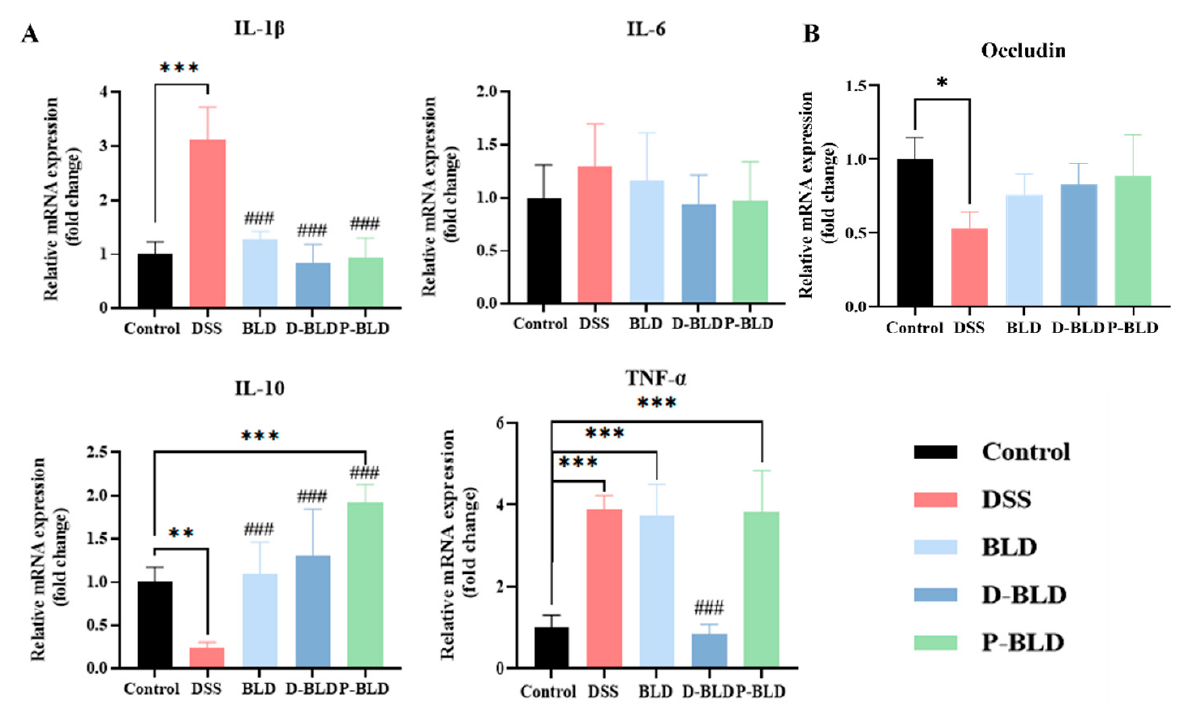
Figure 5. Effect of S. boulardii and its postbiotic elements on colonic inflammation and relative ex- pression levels of mRNA of intestinal barrier-related genes in mice with DSS-induced colitis. ( A ) inflammatory factors. ( B ) Tight junction proteins. Note: Data are expressed as mean ± SD. Compar- ison of significant differences between groups is indicated, where * p < 0.05, ** p < 0.01, *** p < 0.001 compared with Control group; ### p < 0.001 compared with DSS group.